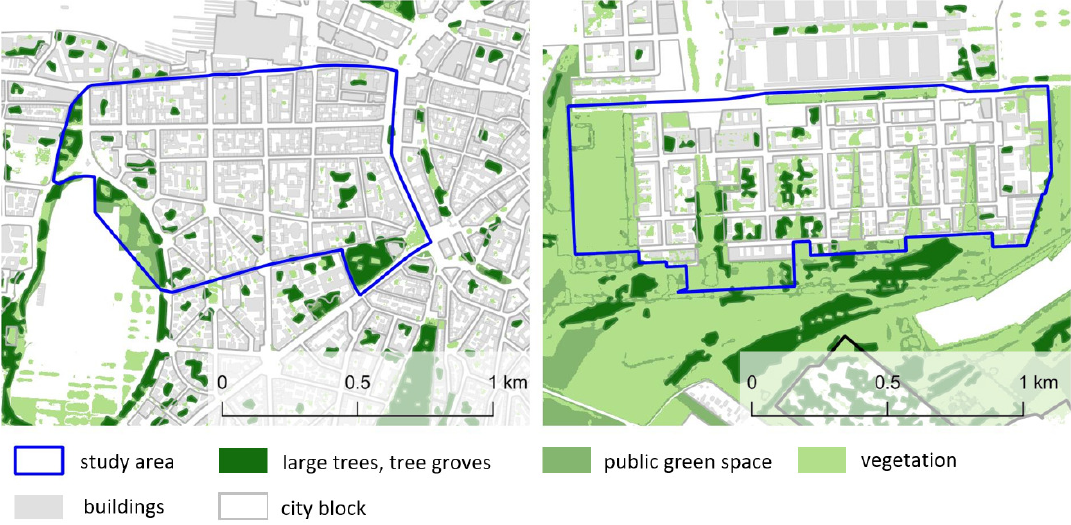
Figure 4. Vegetation within and around the study areas of Bahnhofsviertel (left) and Messestadt (right). Sources: treecover from Street Tree Layer (2018), vegetation from European Settlement Map (2017), city structure from GeodatenService München (2020).